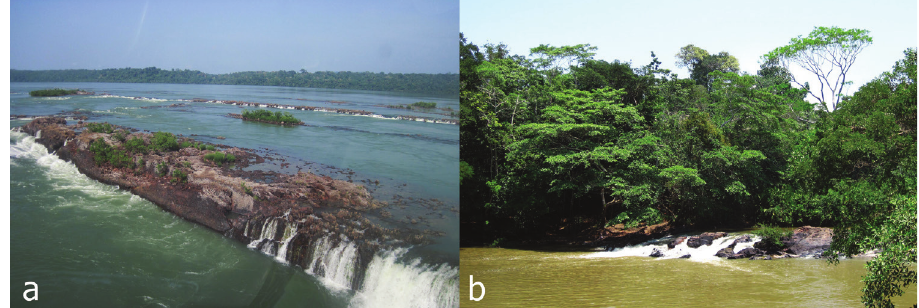
Figure 5. a Habitat at type locality of Pseudancistrus zawadzkii : rio Tapajós, municipality of Itaituba, Pará State, Brazil b habitat at paratype locality: rio Tracuá, Tapajós river basin, municipality of Itaituba, Pará State,